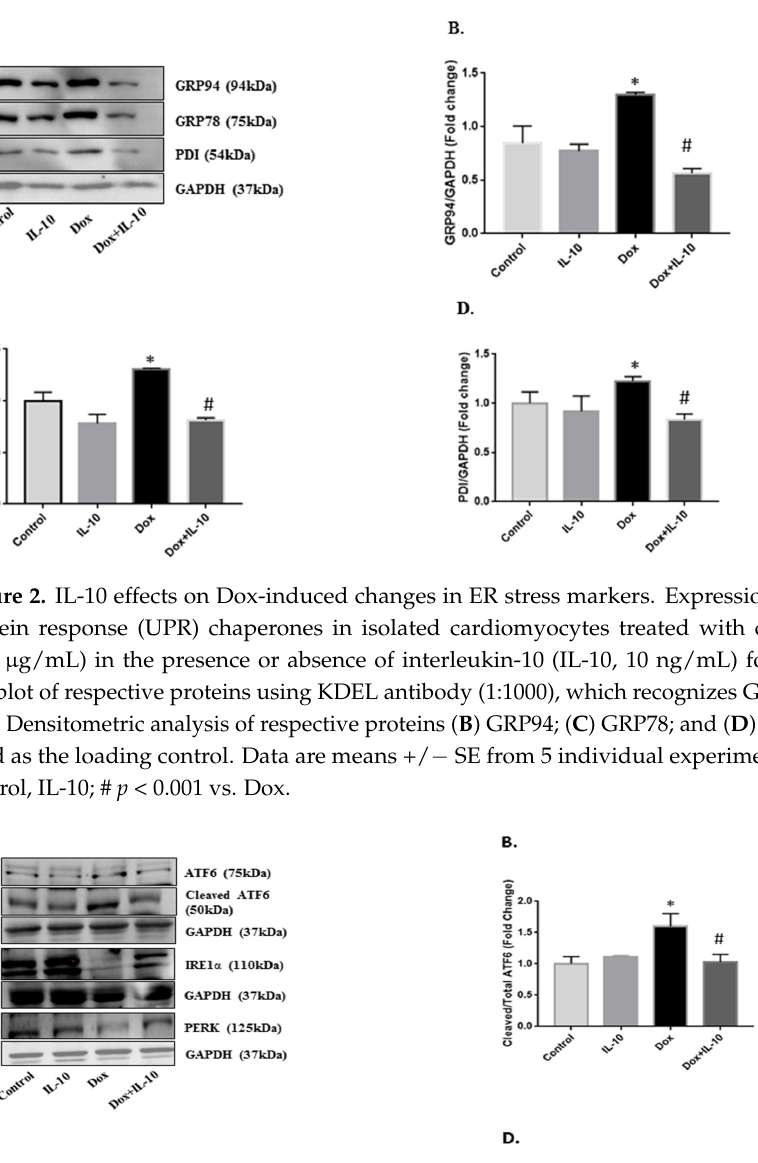
Figure 4. IL-10 effects on Dox-induced ATF6 cleavage and its translocation to the nucleus . Immu- nofluorescence images of total and cleaved activating transcription factor-6 (ATF6) in isolated car- diomyocytes treated with Dox (5.43 µg/mL) in the presence or absence of IL-10, 10 ng/mL for 24 h. ( A ) Cells were fixed and incubated with specific ATF6 antibody (1:100) overnight, followed by secondary antibody labeled with Alexa 647 (Red). DAPI (Blue) was used to locate nuclei. Final